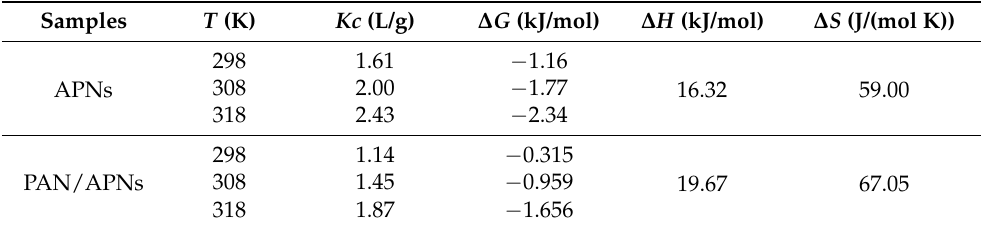
Table 2. Thermodynamic parameters for Cr(VI) adsorption on APNs and